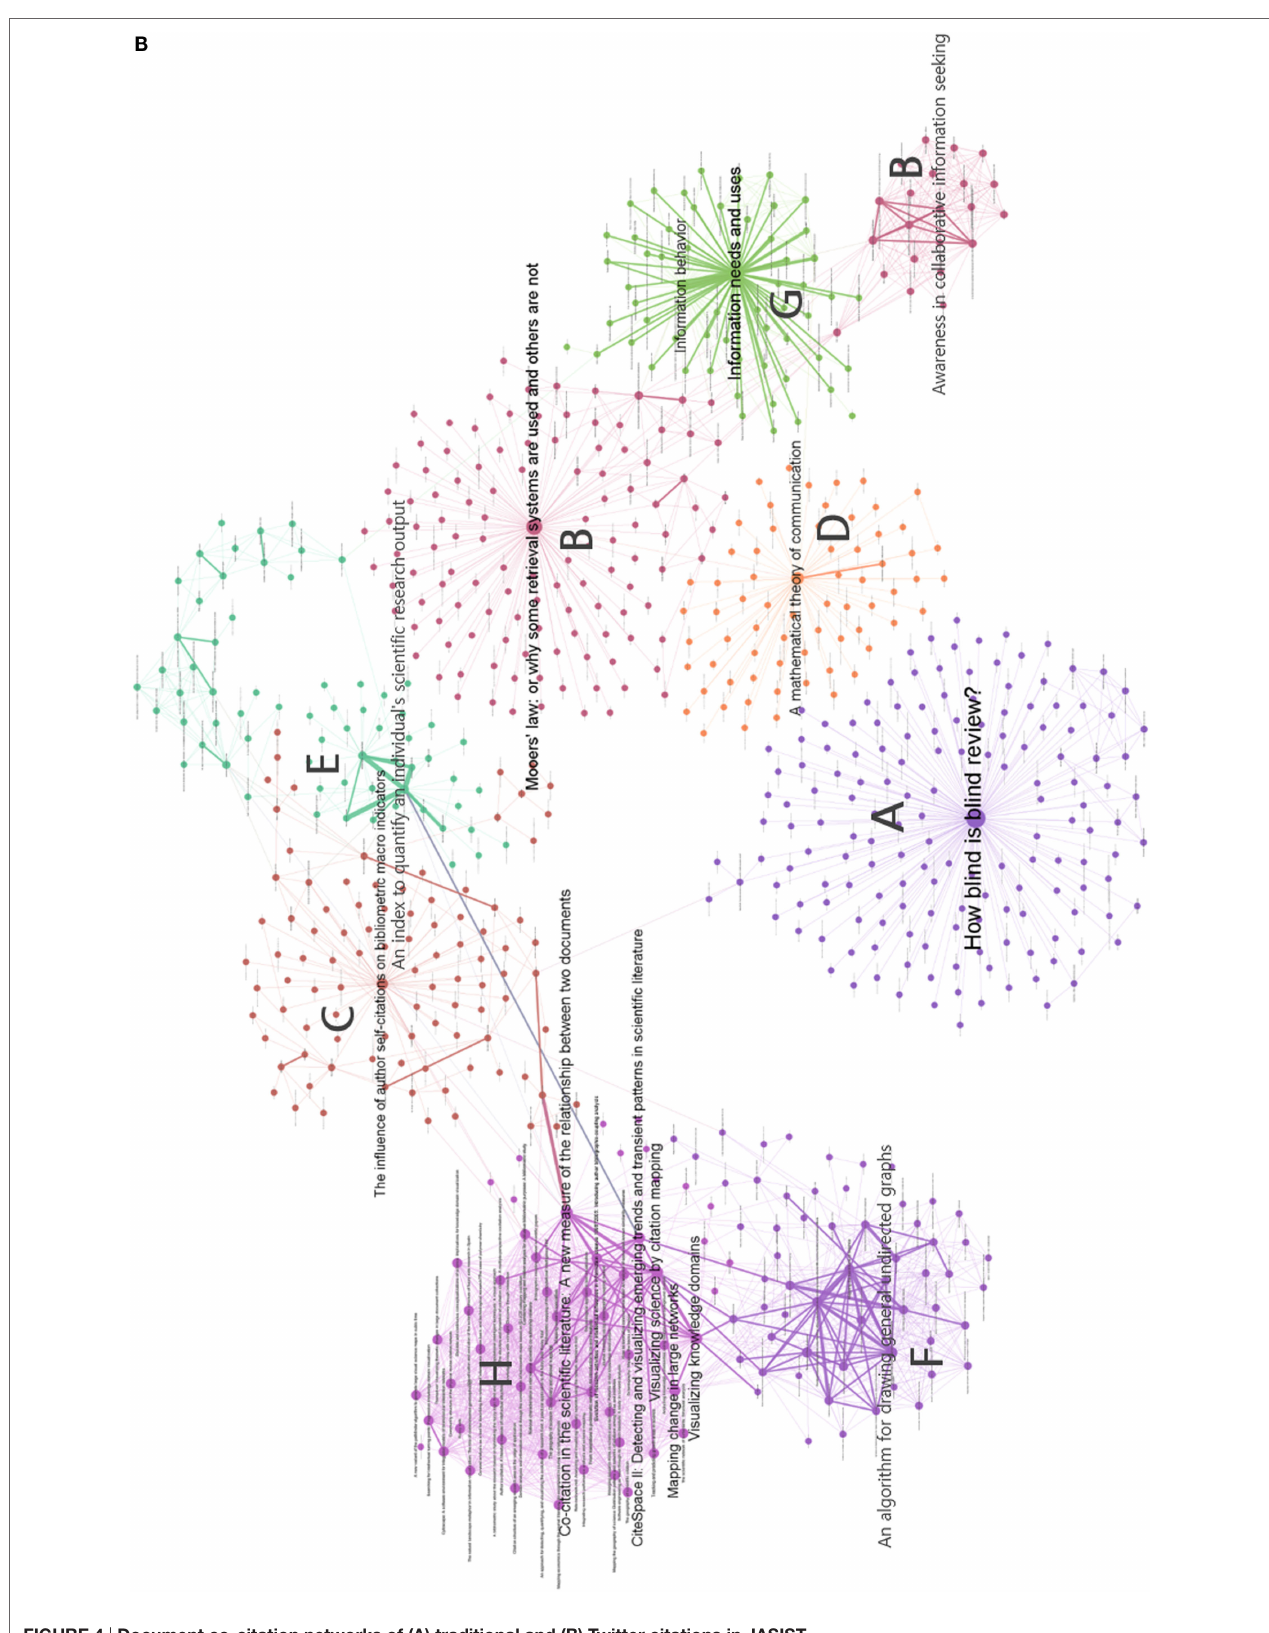
FigUre 4 | Document co-citation networks of (a) traditional and (B) Twitter citations in JasisT